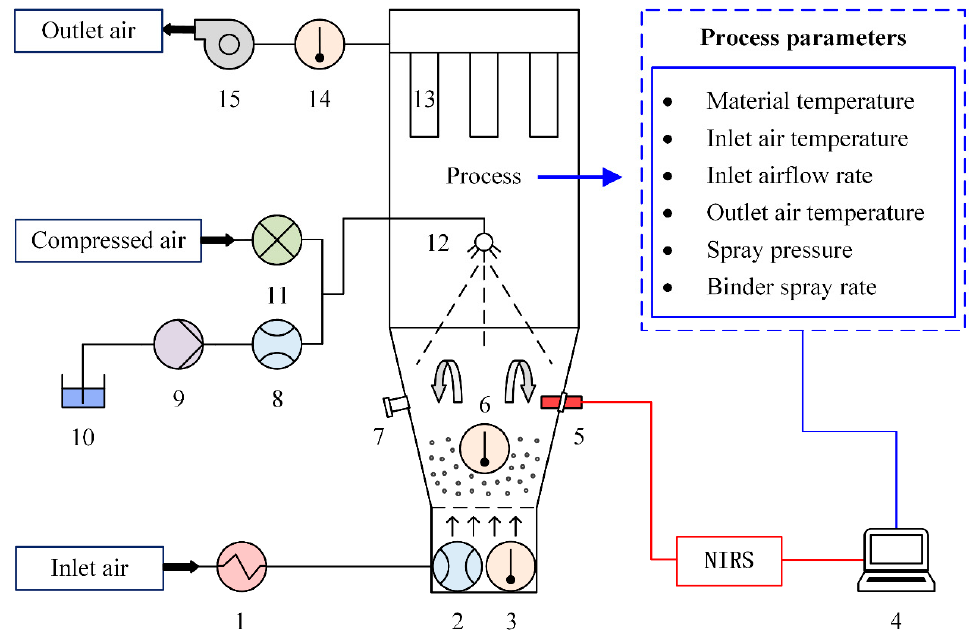
Figure 1. Scheme for data acquisition of the process parameters in top-spray fluidized bed granulation. (1) Electric heater; (2) airflow rate sensor; (3) temperature sensor 1; (4) data acquisition system; (5) in-line probe; (6) temperature sensor 2; (7) sampling port; (8) flowmeter; (9) peristaltic pump; (10) binder liquid; (11) pressure sensor; (12) nozzle; (13) bag filter; (14) temperature sensor 3; (15) exhaust fan.